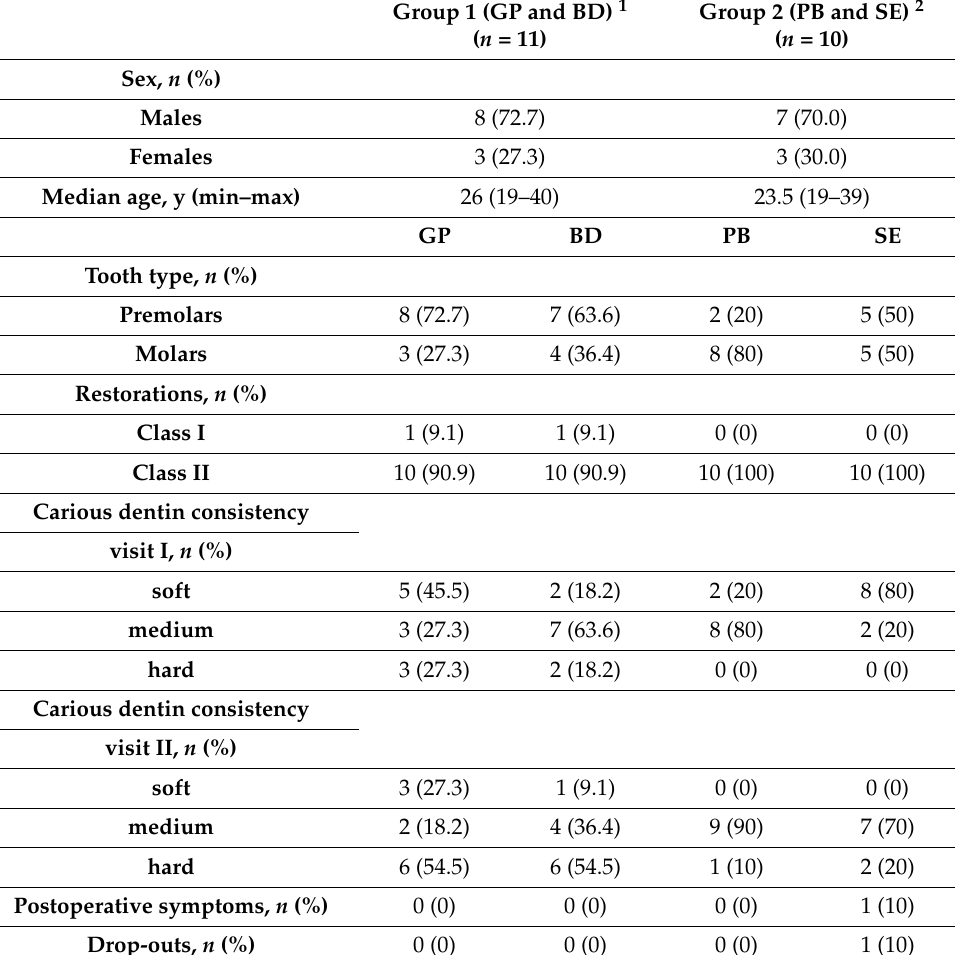
Table 1. Demographic and clinical characteristics of study participants and teeth. Guttapercha (GP), Biodentine TM (BD), Clearfil TM Protect Bond (PB), Clearfil TM SE Bond 2